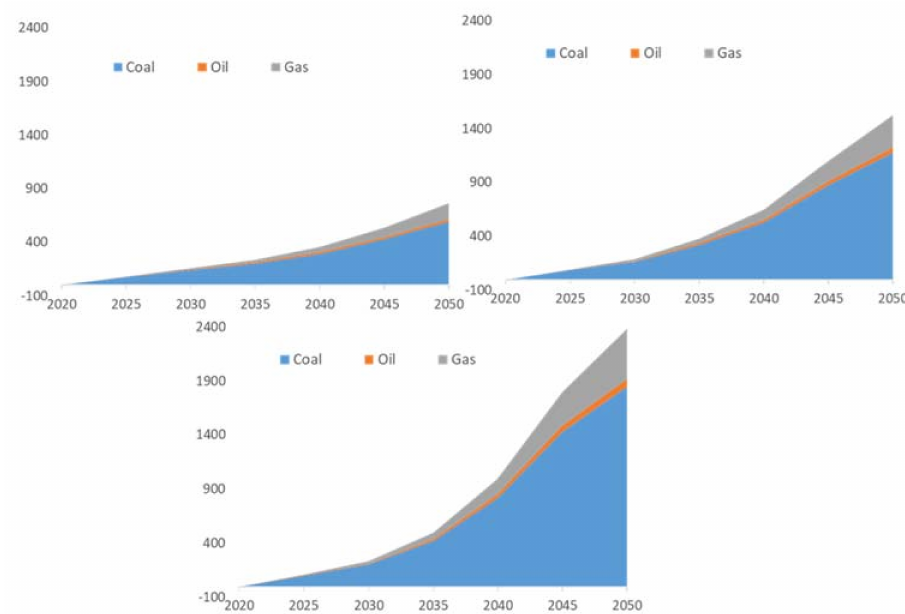
Figure 10. Global Stranded assets in power generation over 2020–2050 by plant type (in billion-bn $ 2015), upper left: 2DEG-OPT scenario, upper-right: 2DEG-NOCCS, lower: NOCCS-Delayed, Source: PROMETHEUS model